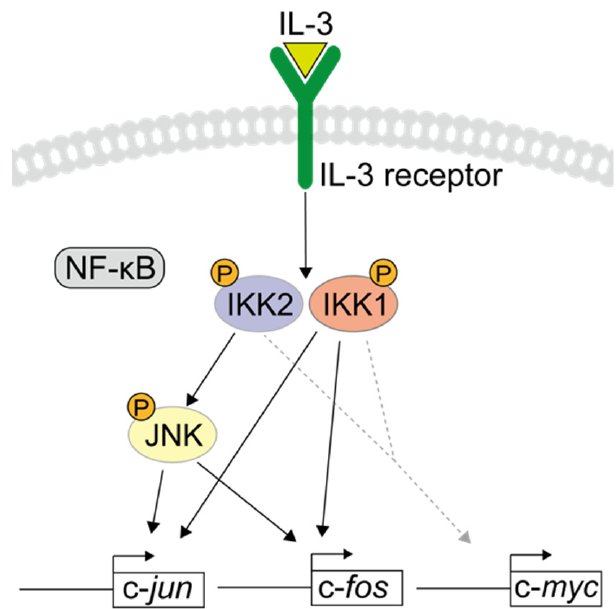
Figure 5. A putative model for IKK-mediated IL-3 signaling to induce expression of IEGs. Although IKK2 is the main regulator of canonical NF- κ B signaling, activation of IKKs by IL-3 did not induce degradation of I κ B and nuclear translocation of p65. The ability of members of the β c cytokine family to activate canonical NF- κ B signaling is unclear. Electrophoretic mobility shift assays have shown that GM-CSF or IL-3 stimulation enhanced the DNA-binding activity of NF- κ B [46,48,49]. Although IL-3 was found to induce the nuclear translocation of p65 in mouse embryonic fibroblasts [49], the nuclear translocation of p65 and the degradation of I κ B were not detected in bone marrow mast cells and immune cell lines [33,46]. Despite the inconsistency among experiment assays and cell types, our findings indicate that IKKs can mediate IL-3 signaling in a canonical NF- κ B-independent manner. IKK1 has been found to regulate a non-canonical NF- κ B pathway that induces the nuclear translocation of the RelB/p52 NF- κ B complex [29]. In contrast to the rapid activation of canonical NF- κ B signaling, activation of non-canonical NF- κ B signaling is slow due to the requirement for de novo protein synthesis [50,51]. Because the transcription of IEGs occurs within 20 min of stimulation, non-canonical NF- κ B signaling was likely unrelated to IL-3-induced IEGs